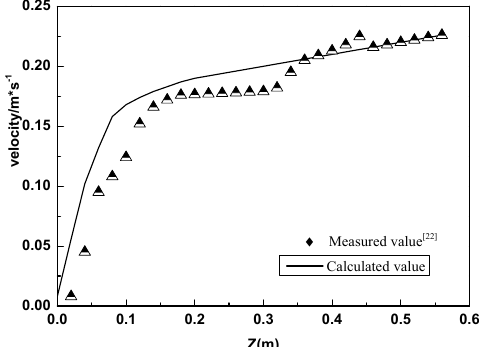
Figure 5. Velocity distribution along the center of the down-snorkel in the ladle.